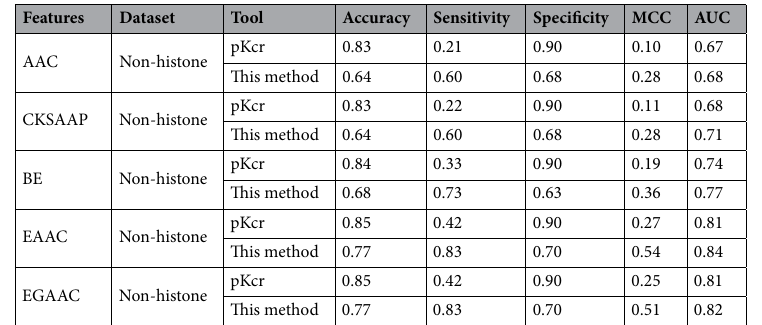
Table 3. Performance comparison between our method and existing available crotonylation site prediction tools (pKcr). The above comparison indicates that our study is more robust and gives a more balanced performance than the pKcr method.